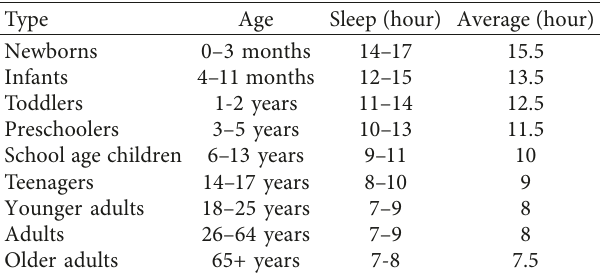
Table 3: Recommended sleep durations by age.